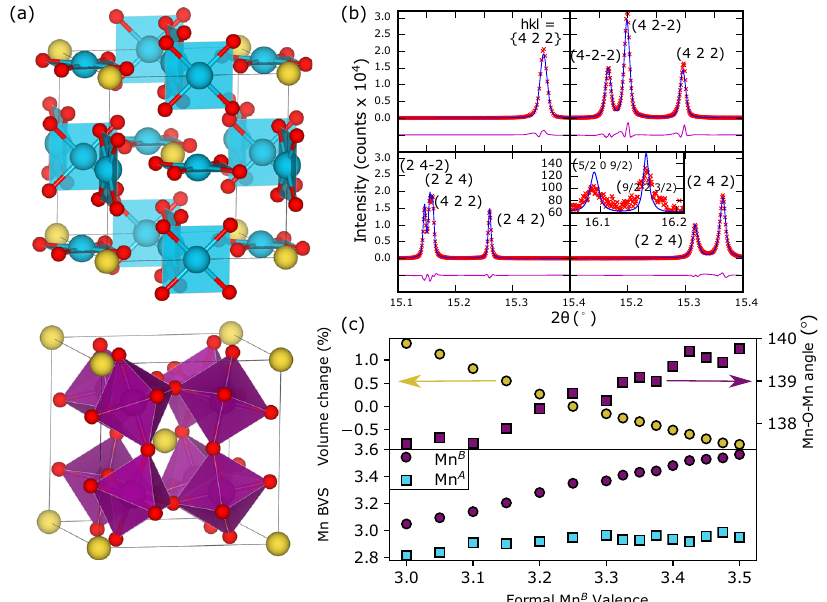
Fig. 1 Structure an doping of the prototype system. a The high-symmetry structure of the AMn 7 O 12 prototype system with square planar coordinate Mn A ’ (top), and octahedrally coordinated Mn B (bottom) illustrated. The variable A-sites = Na 1 − x Ca x and La 1 − x Ca x used to dope the structure are shown as yellow spheres. b Diffraction data on AMn 7 O 12 , showing cubic Im (cid:1) 3 Na 0.9 Ca 0.1 Mn 7 O 12 (top left, at 700 K), rhombohedral R (cid:1) 3 La 0.4 Ca 0.6 Mn 7 O 12 (top right, at 80 K), monoclinic I 2/ m LaMn 7 O 12 (bottom left, at 80 K) and pseudo-tetragonal ( C 2/ m ) Na 0.4 Ca 0.6 Mn 7 O 12 (bottom right, at 80 K) with inset superstructure peaks. Peaks are indexed with respect to Im (cid:1) 3 parent symmetry. c Change in volume, Mn B – O – Mn B bond angle and bond valence sums (BVS) as a function of formal Mn B valence state at 700